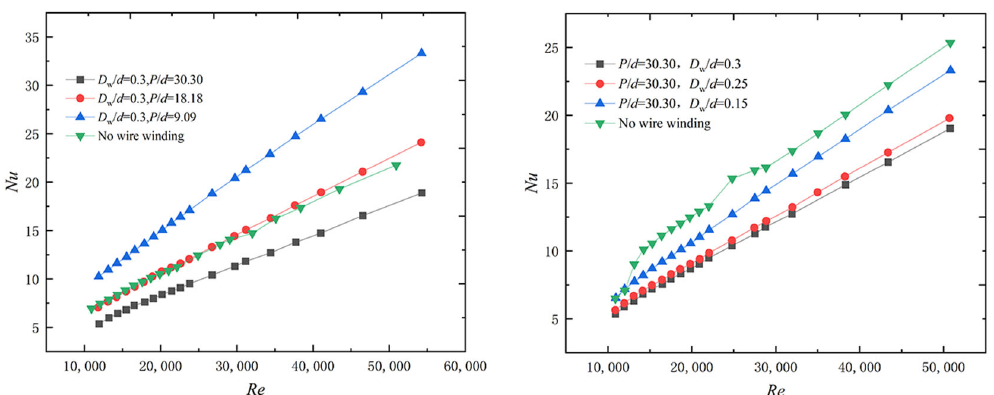
Figure 21. Variation of Nusselt number with wire winding parameters [19].